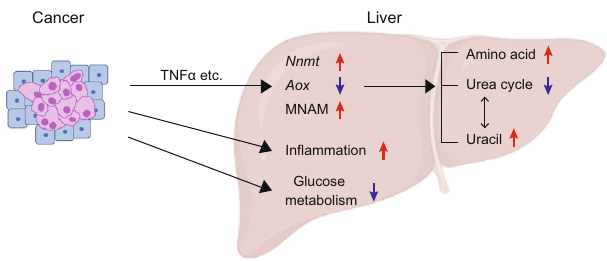
Fig. 6 Graphical summary. Solid cancers increase NNMT and MNAM in the liver, consequently causing dysregulation of the urea cycle and uracil biogenesis. On the other hand, NNMT is not required for abnormalities in glucose metabolism and enhancement of in